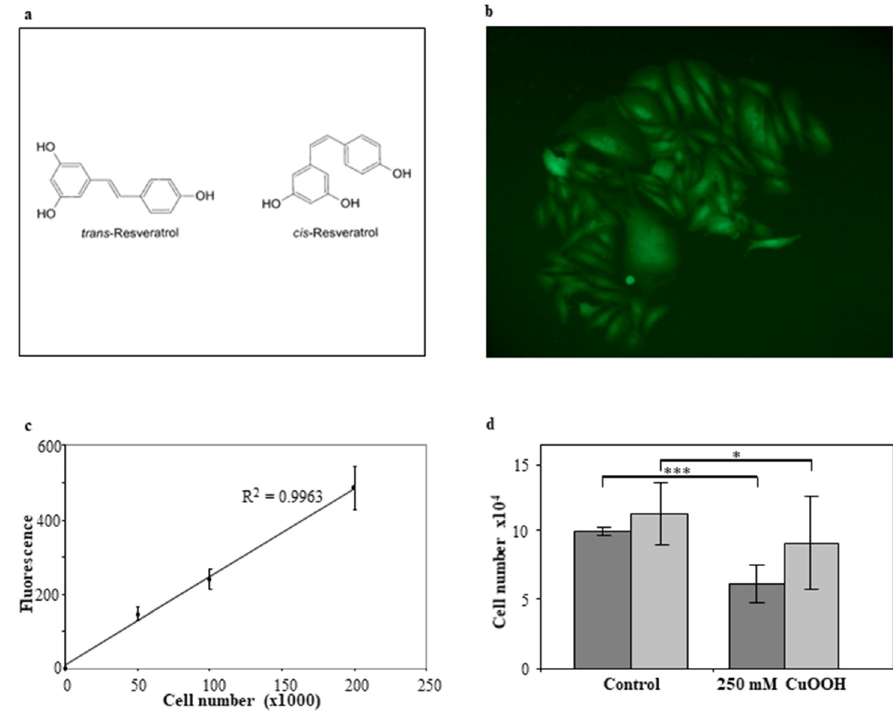
Figure 1. Resveratrol structures, florescent human keratinocyte cells, relation between the number of NCTC-GFP cells and fluorescence intensity, and the effect of CuOOH treatment: Panel ( a ): Resveratrol cis- and trans-isomers chemical structures. Panel ( b ): Microphotograph showing fluorescent NCTC-GFP (magnitude 20X). Keratinocytes exhibit small differences in morphology/shape due to the micro-environment in which they are expanding, i.e., cells inside the monolayer are more rounded, whereas cells growing at the edge of the monolayer are more elongated. Panel ( c ): Relation between the number of NCTC-GFP cells and fluorescence intensity. Samples containing an increased number of cells, ranging from 3.125 × 10 3 to 10 5 cells/cm 2 , were analyzed by spectrofluorimetric reading. Five different sets of samples were tested at different times. Each value was reported in the graph as a function of the corresponding cell number. Bars represent the standard deviation. The linear relation between cell number and fluorescence intensity was represented by the R 2 value (0.9963). Panel ( d ): Effect of CuOOH treatment on cell number (dark gray) and proliferation (light gray). Horizontal bars indicate a statistically significant difference (*: p < 0.05; ***: p < 0.0005).